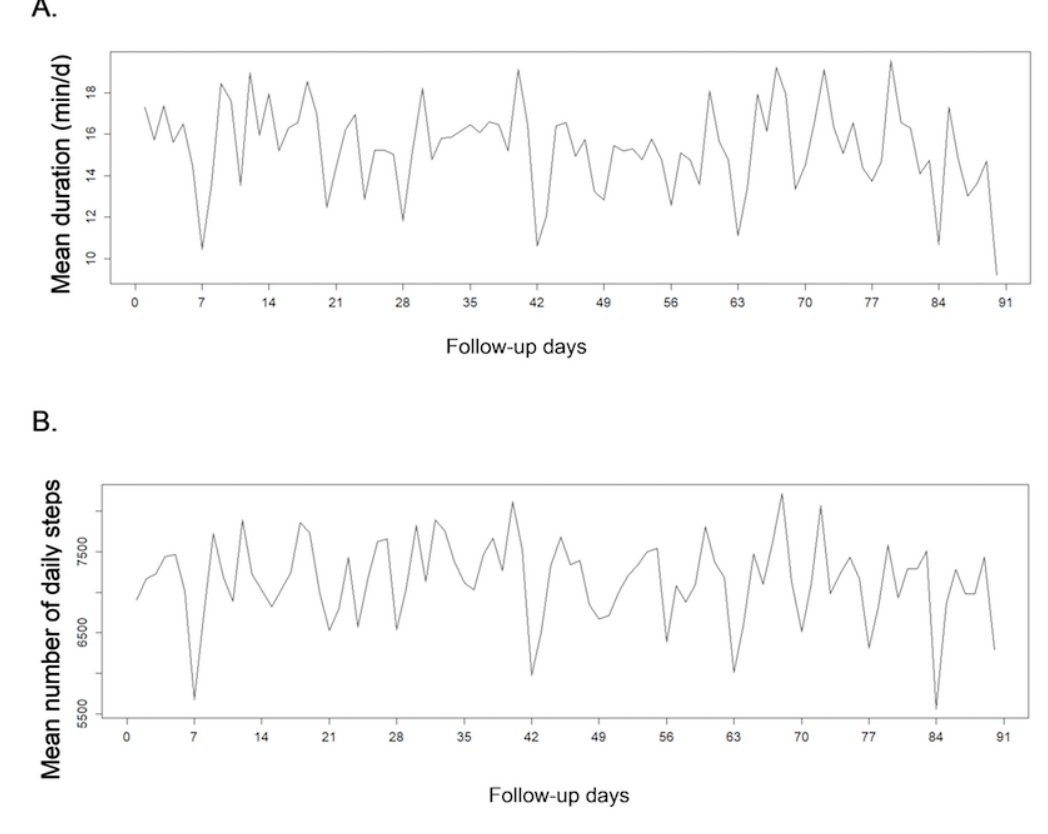
Figure 5. Weekly fluctuations of physical activity in 74 axialspondyloarthritis patients over 90 days, according to: (A) moderate to intense activity duration and (B) number of